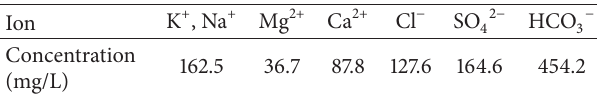
Table1:Waterqualityparametersoftheon-siteinjectionwaterfrom Honggang oilfield in